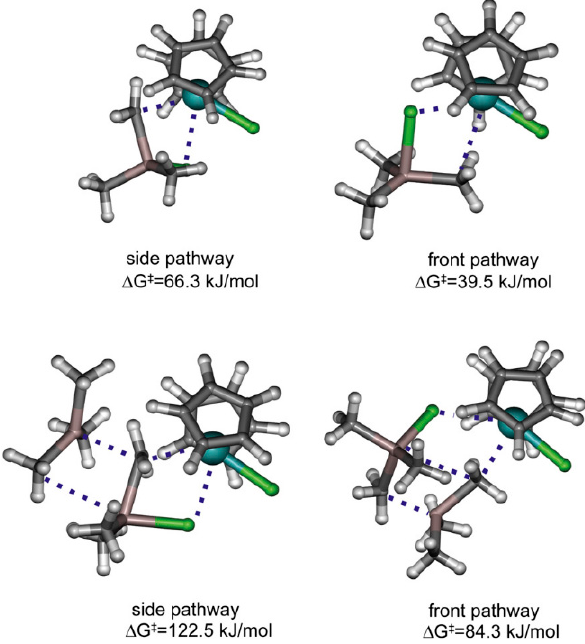
Figure 11. Illustration of transition states for the alkylation of Cp 2 ZrCl 2 with Me 3 Al (top) and Al 2 Me 6 (bottom). Reprinted with permission from [123]. Copyright (2012) Elsevier B.V.